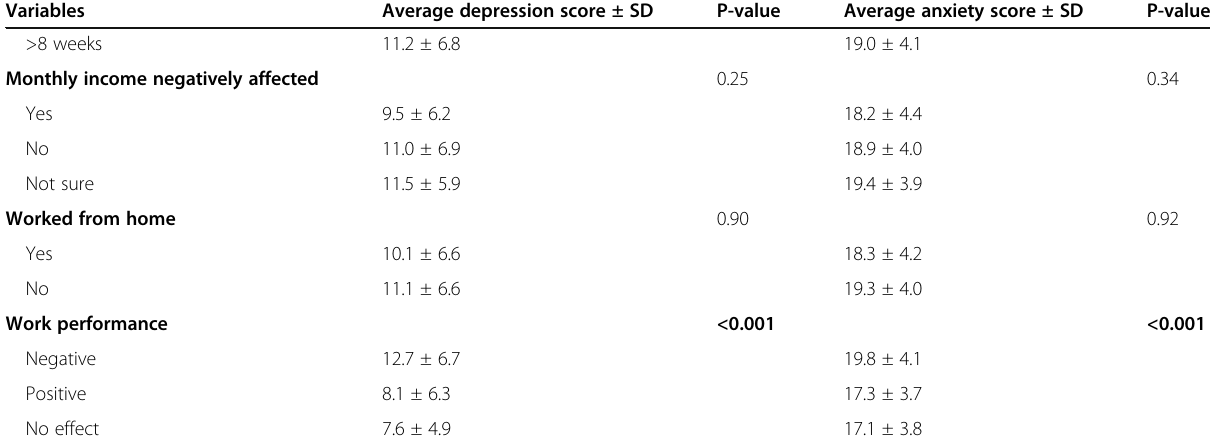
Table 2 Target symptoms stratified according to participant ’ s baseline characteristics (Continued) Variables